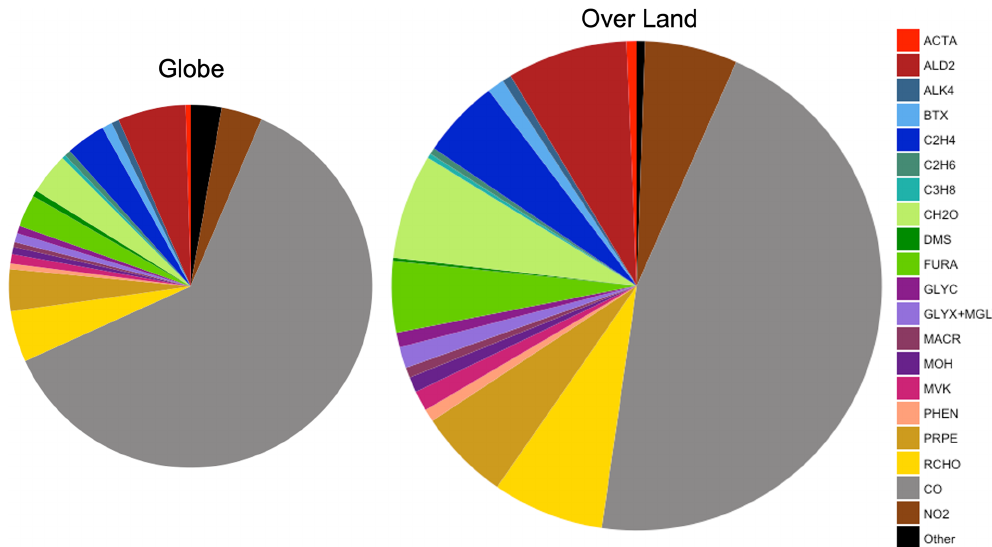
Figure 9. Average global annual mean contribution of chemical species and species groups to simulated surface fire cOHR in 2019 using GFED4s DM for the entire globe and over land only. The two pie charts are approximately sized by their relative fire cOHR (0.16s − 1 globally and 0.29s − 1 over land). BTX is benzene, toluene, and xylenes. Other ( n = 56) includes species whose annual mean fire cOHR is equal to or less than 0.0004, which includes ozone.